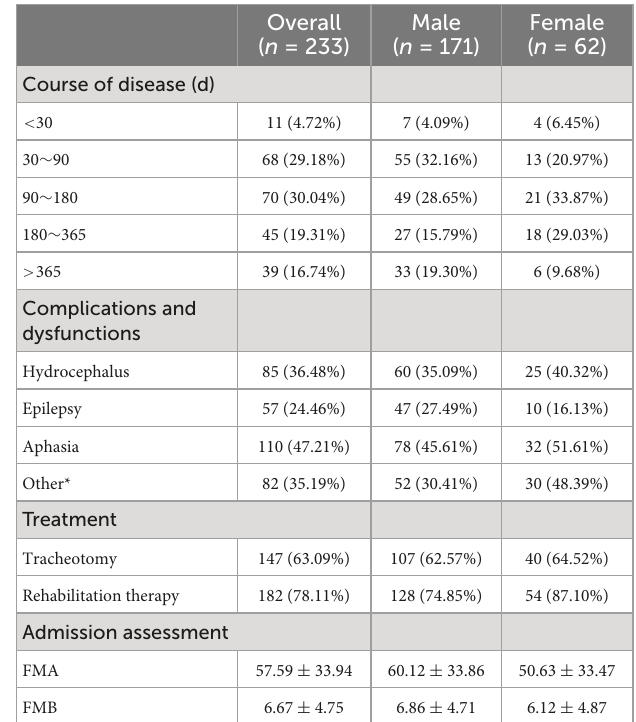
TABLE 1 The information of predictive